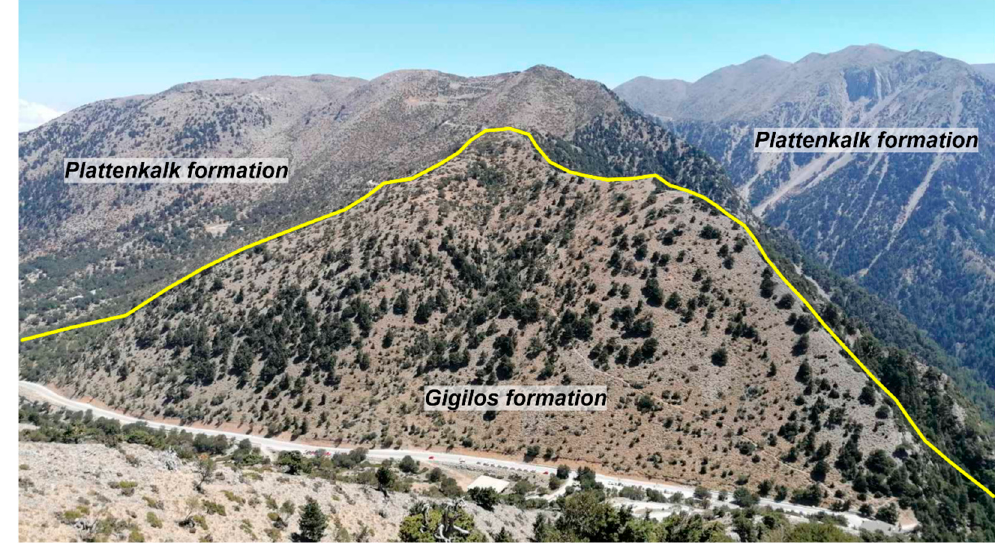
Figure 3. Contact (yellow line) between the Gigilos and Plattenkalk formations.